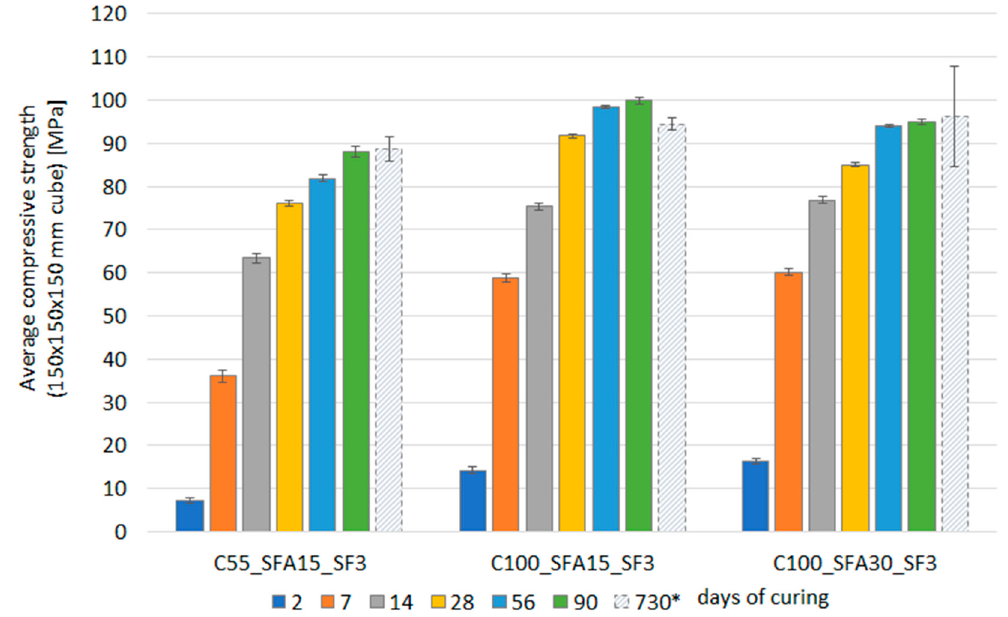
Figure 4. Average compressive strength of low-clinker HPC; *—compressive strength values tested on two specimens, converted using conversion factor of 0.86 for cylindrical specimens.